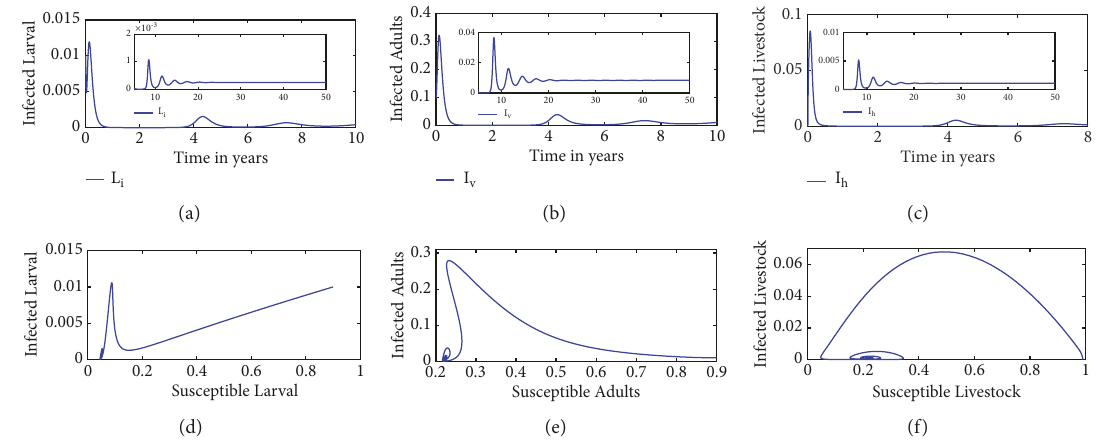
Figure 4: Time series and phase diagrams plot. The inner figures describe the temporal evolution of 𝐿 𝑖 , 𝐼 V ,𝐼 ℎ after the transient period for 𝑅 𝑐 = 2.1002 , while for the outer figures 𝑅 𝑐 = 1.0012 . Parameter values used for 𝑅 𝑐 0 0 0.35, 𝛼 = 256/360 , 𝛾 = 1/4,𝑚 = 1.5,𝑞 = 0.2,𝜃 = 1/10,𝜇 = 1/18, 𝑟 = 1/12, 𝛿 = 0.4 and parameter values used for 𝑅 𝑐 ℎ V 𝐿 Table 1 of Section A-3 of Supplementary